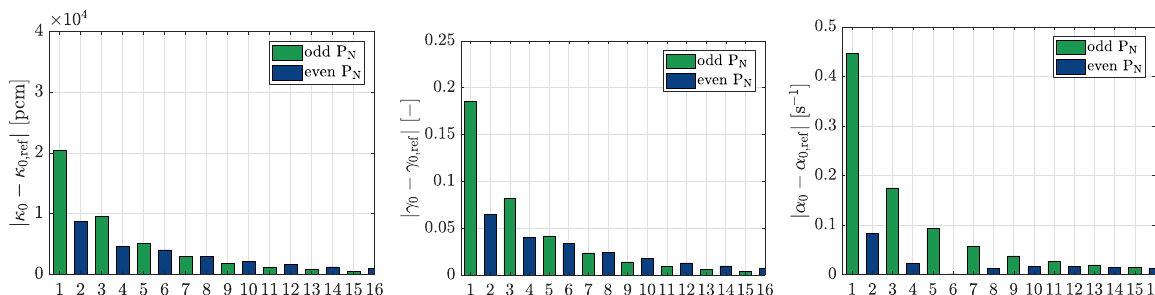
Figure 2: κ , γ , and α eigenvalues convergence as a function of the angular approximation order with Mark BCs using the roots of L